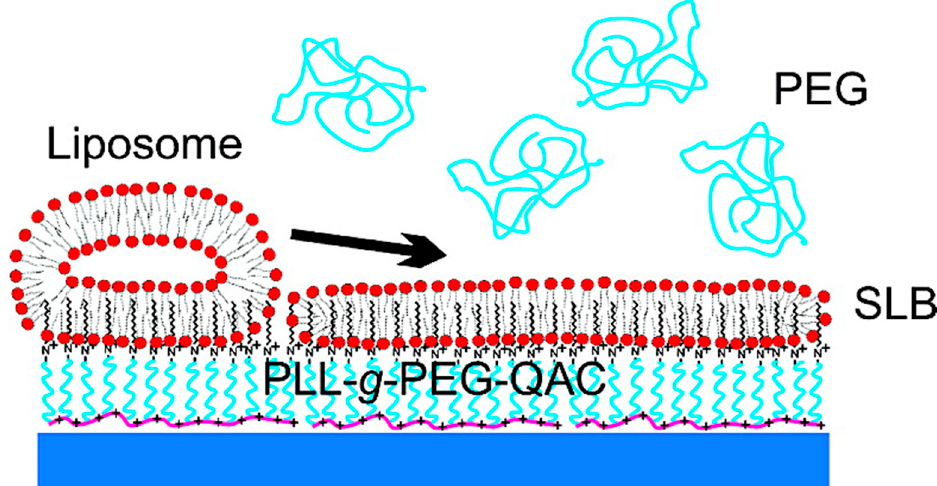
Figure 2. Schematic of the PLL- g -PEG-Quaternary ammonium compound (QAC) platform for liposome capture and induced rupture to form supported lipid bilayer (SLB) (Adapted with permission from reference 27. Copyright 2009 American Chemical Society).